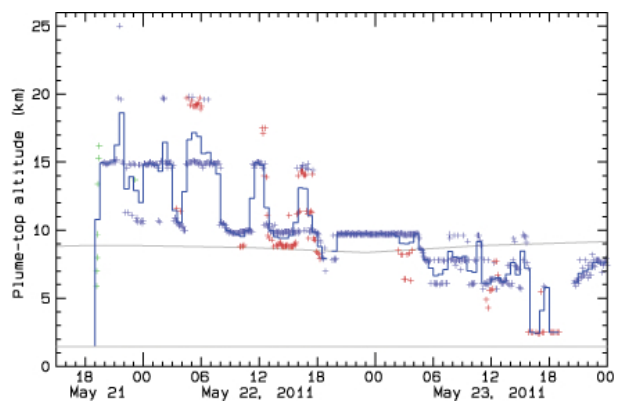
Figure 5. The time series of the 5-min detected plume-top altitude (kma.s.l.) during the first 53h of the eruption. Altitude estimates are from the C-band weather radar (blue) and the X-band mobile radar (red), as well as the initial rise of the plume estimated from photographs (green). The altitude of the tropopause, observed by Keflavík radiosondes is shown at about 9kma.s.l. (gray). The lower gray line represents the altitude of the Grímsvötn caldera. A 30-min average plume-top altitude of all the estimates is shown by the blue